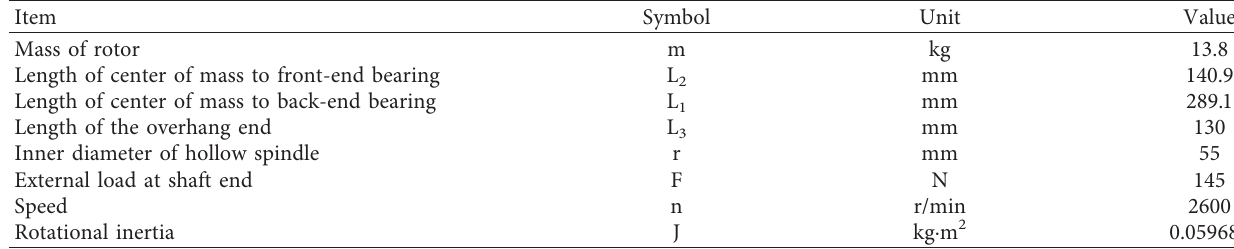
Figure 1: Schematic diagram of force analysis of the spindle system. Table 1: Structure and working condition parameters of the spindle system rotor.